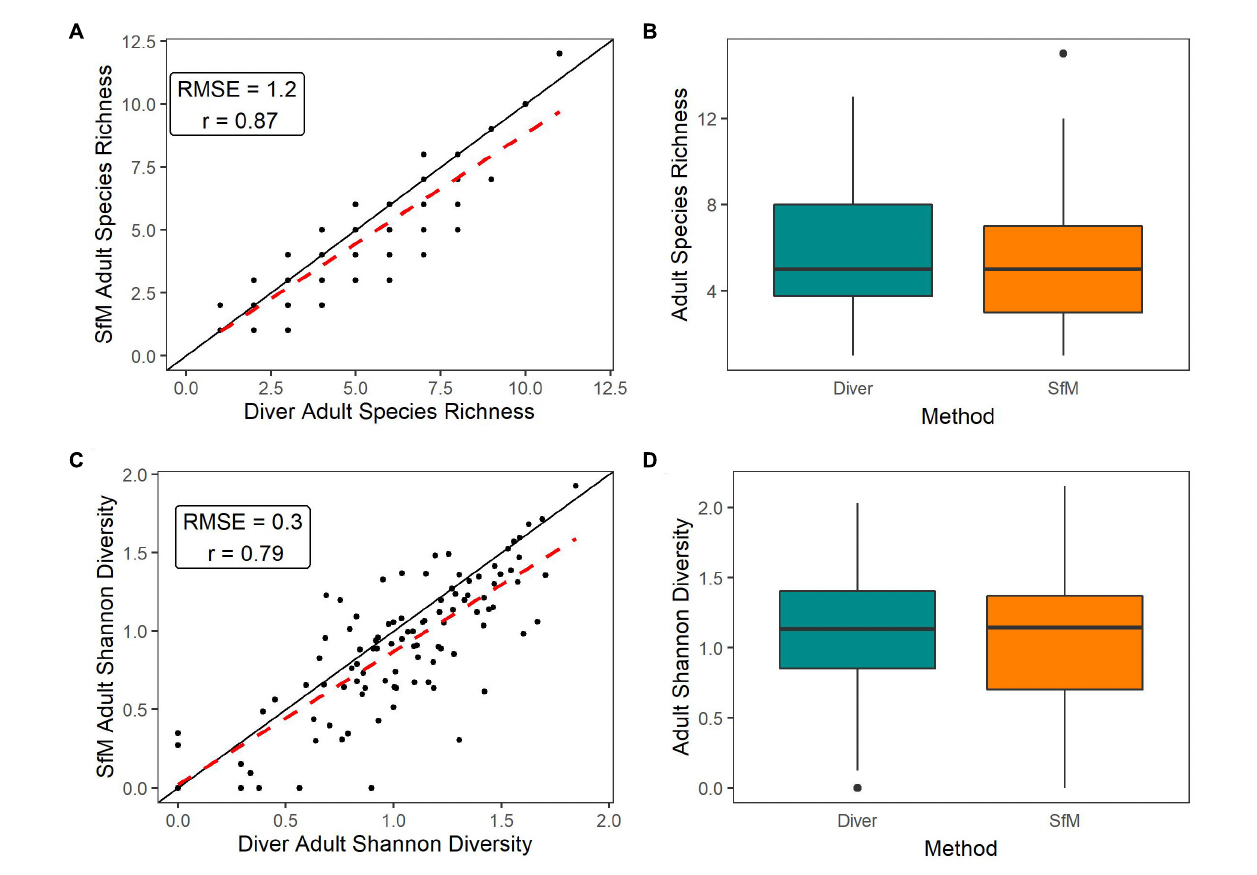
FIGURE 6 | (A,C) 1:1 Plots of the paired site-level (points) SfM versus Diver data for adult species richness and adult Shannon-Wiener diversity, respectively. Black line is the 1:1 line, red dashed line is the linear regression line between methods. (B,D) Boxplots of site-level data by method type for adult species richness and adult Shannon-Wiener diversity, respectively. No significant between methods was detected using LMMs and LRTs ( α = 0.05) (B,D)